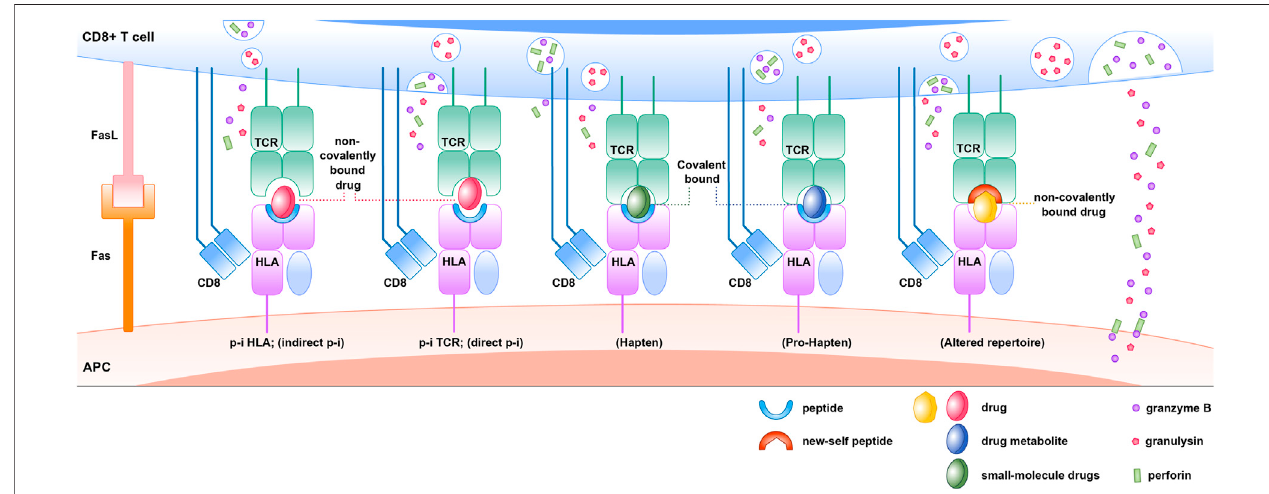
FIGURE 6 | Immune mechanisms of HLA, drug, peptide, and TCR associated drug hypersensitivity reactions.